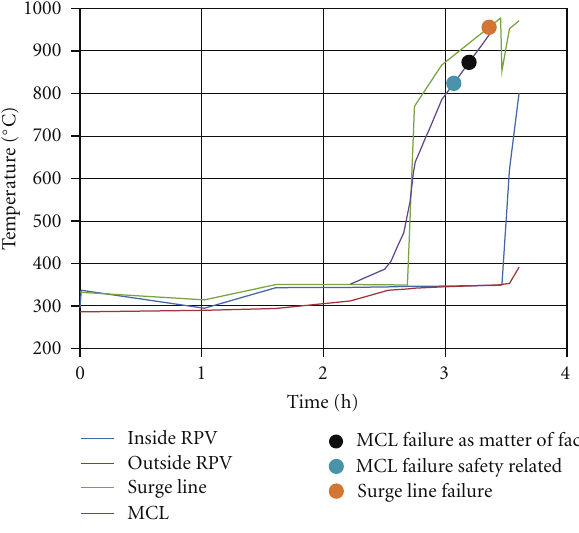
Figure 19: Temperatures versus transient time for di ff erent posi- tions together with times and temperatures of failure for MCL and surge